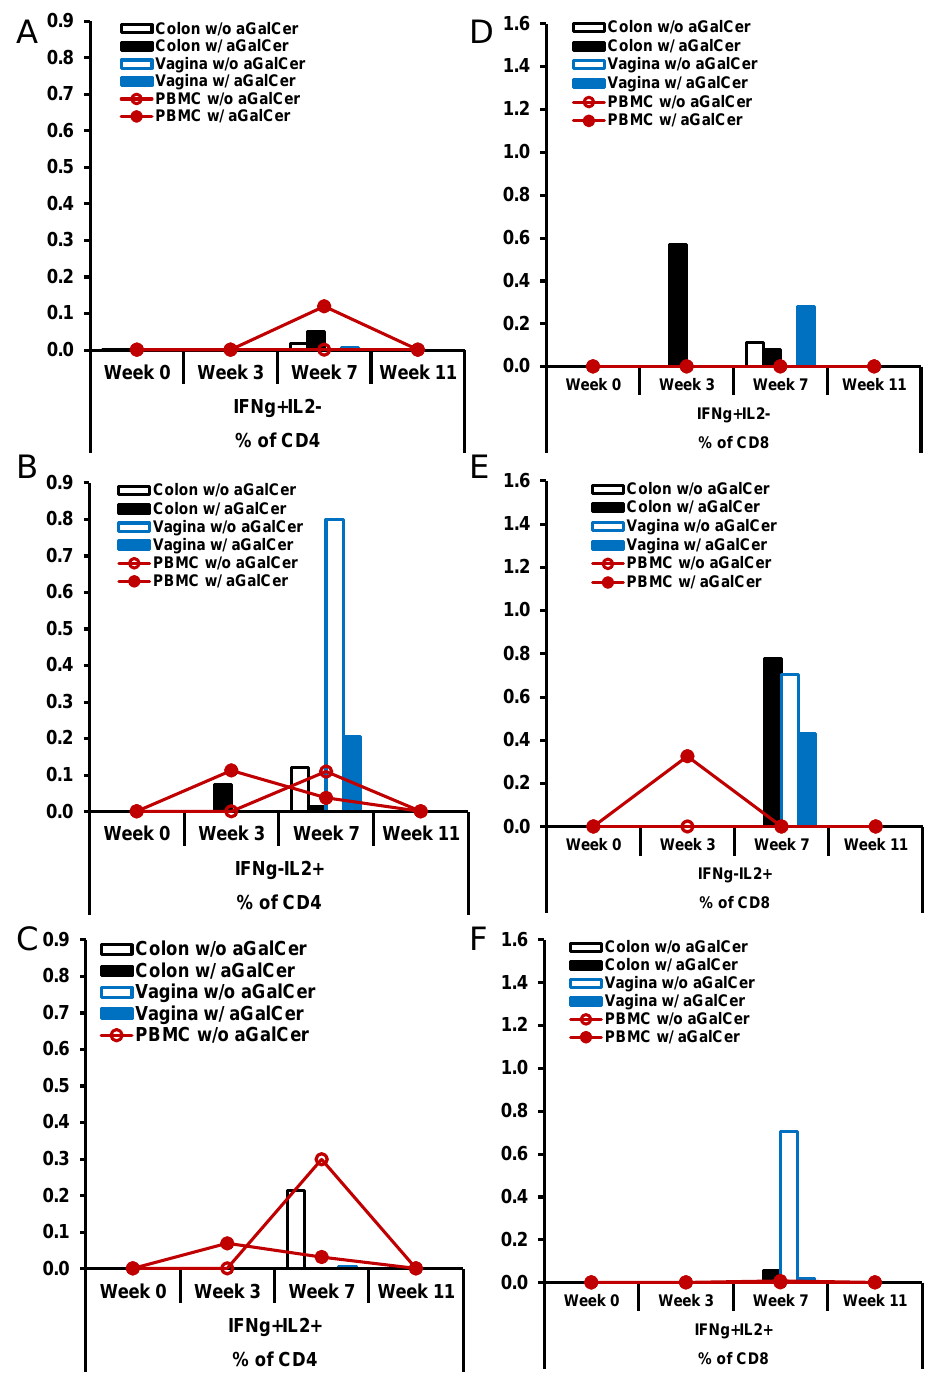
Figure 6. Enhancement of antigen-specific CD4 and CD8 T cells responses after sublingual immunization with HD-Ad HIV envelope in the presence of α-GalCer adjuvant: Single cell suspensions prepared from biopsy tissues of colon and vagina along with PBMC from two rhesus macaques immunized by the sublingual route with the HD-Ad vector encoding the HIV-1 envelope protein (10 11 vp) alone ( n = 1) or along with α-GalCer (125 µg; n = 1), open and closed symbols, respectively, were analyzed by flow cytometry for IFN-γ and/or IL-2 producing CD4 and CD8 T cells. Various tissues at different time points post immunization showing percentages of CD4 T cells ( A – C ) and CD8 T cells ( D – F ) producing IFN-γ alone (IFN-γ + IL2 − ), IL-2 alone (IFN-γ − IL2 + ) or both (IFN-γ + IL2 + ). A